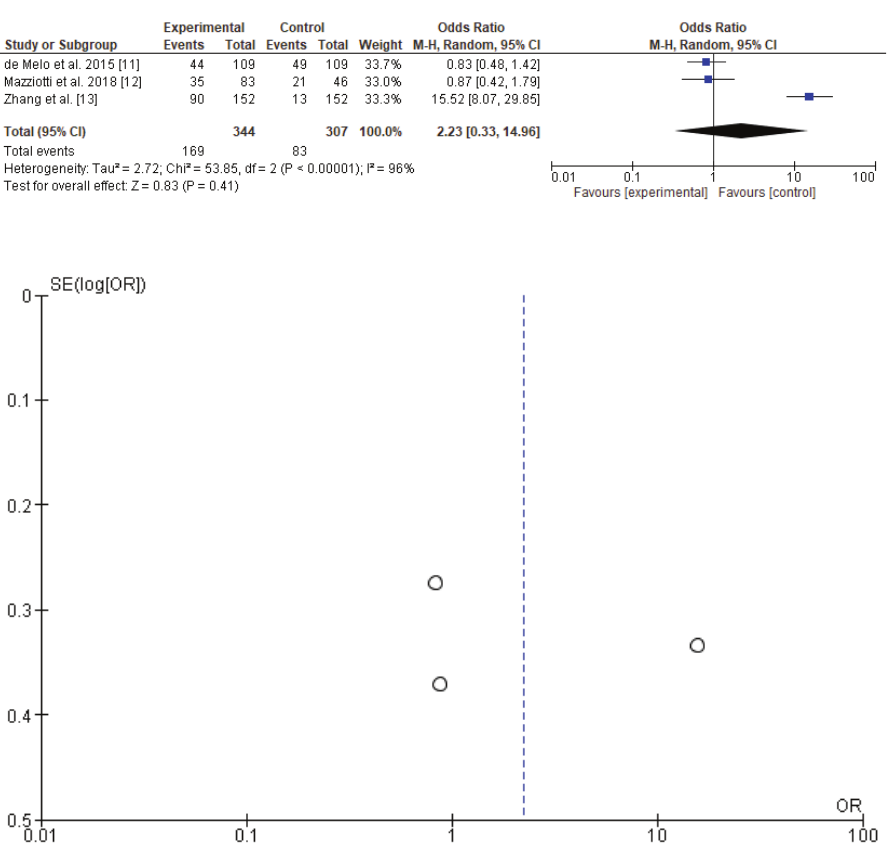
Figure 3 : The effect of long thyroid-stimulating hormone (TSH)-suppressive therapy (following surgery for differentiated thyroid carcinoma) on bone mineral density